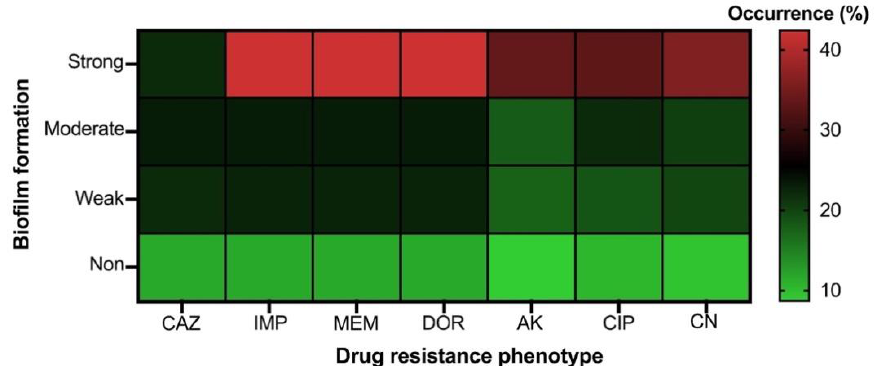
Figure 2. A heatmap demonstrating the percent distribution of 172 carbapenem-resistant A. baumannii isolates from nosocomial biofilm-forming and antimicrobial-resistant samples. The color band depicts the percentage of biofilm features associated with a particular drug-resistant phenotype. GraphPad Prism 9 was used to generate the heatmap (La Jolla, CA, USA). CAZ, ceftazidime; IPM, imipenem; MEM, meropenem; DOR, doripenem; AK, amikacin; CIP, ciprofloxacin; CN, gentamicin.